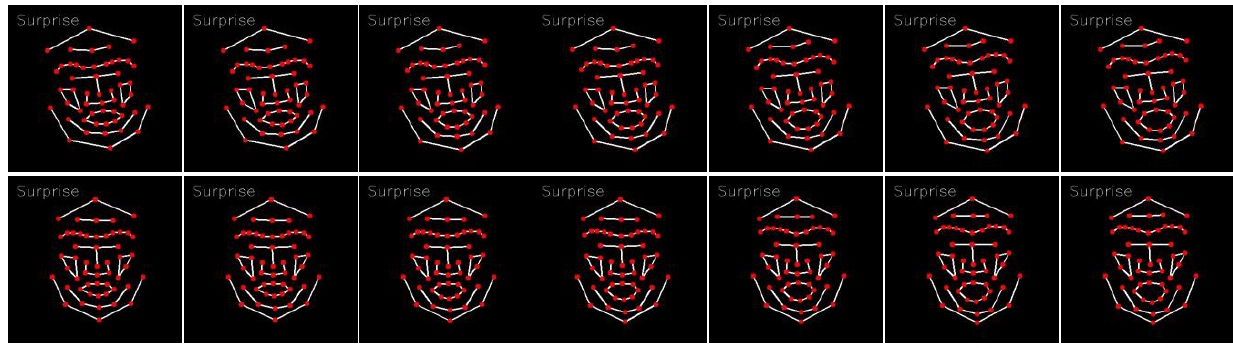
Figure 3. Example of landmark tracking sequences before ( First row) and after ( Second row)